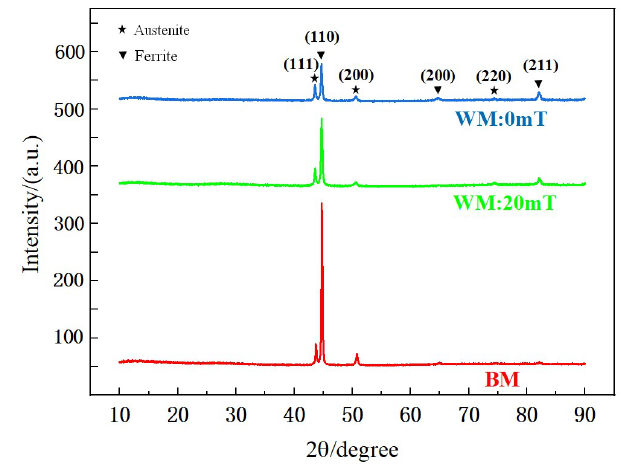
Figure 6. The XRD patterns in the different samples.